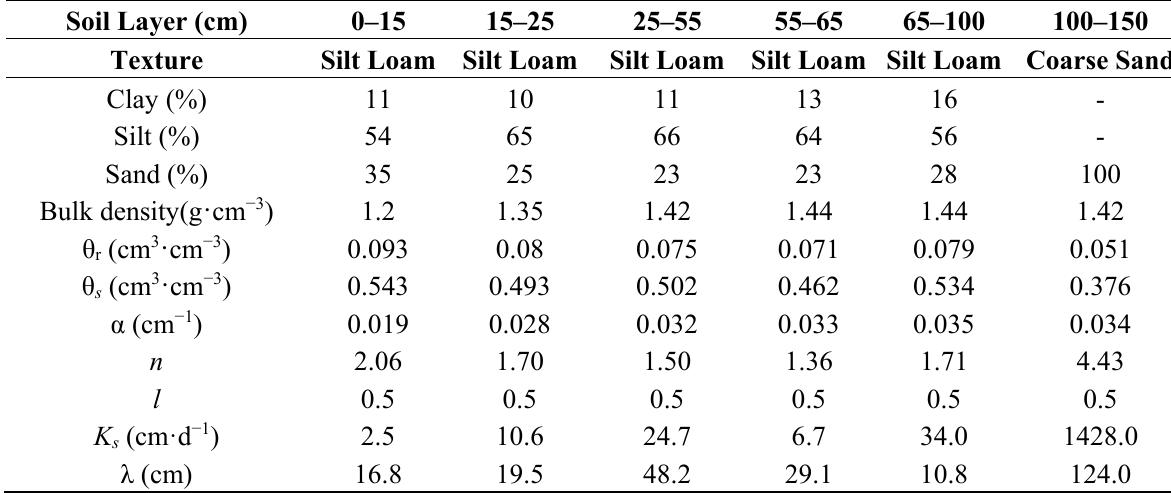
Table 1. Soil physical properties and calibrated parameters at the study